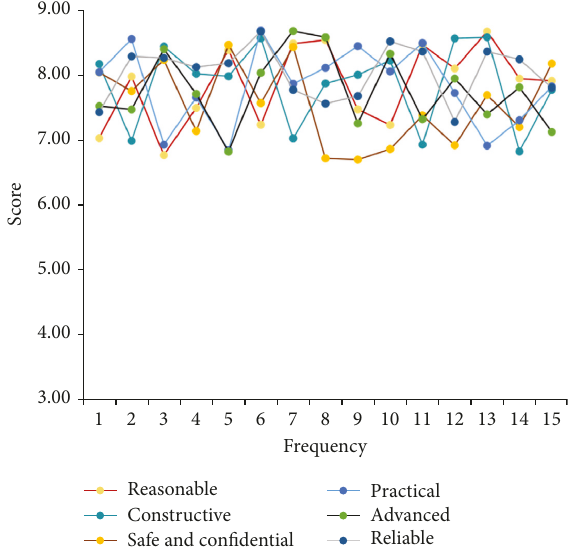
Figure 5: Modeling method